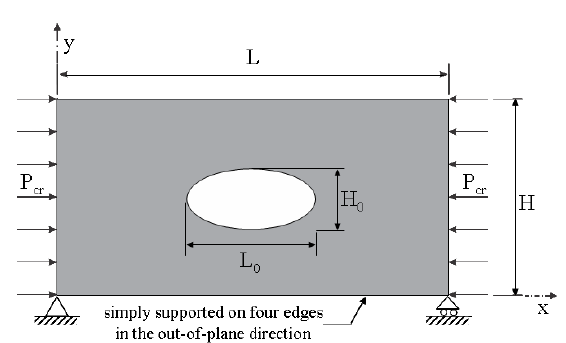
Figure 3. Plate with centered elliptical hole.